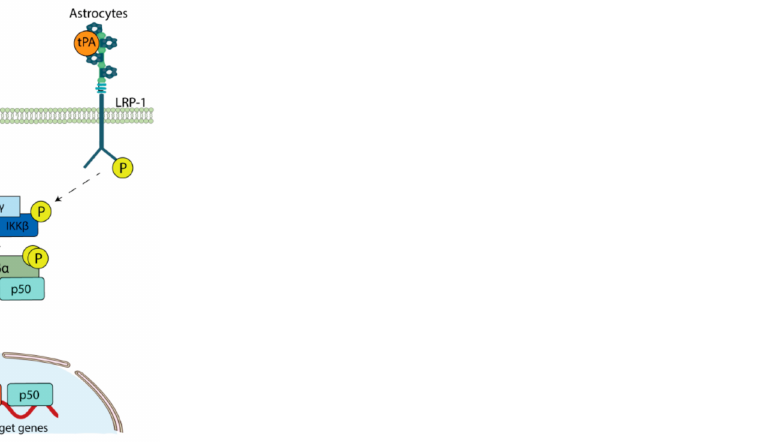
Figure 3. Mechanisms of tPA-induced NF- κ B activation. Representative diagram of the proposed mechanisms whereby tPA activates the NF- κ B pathway in the kidney and cerebral cortical astrocytes. In both cases, IKB α phosphorylation is followed by the nuclear translocation of